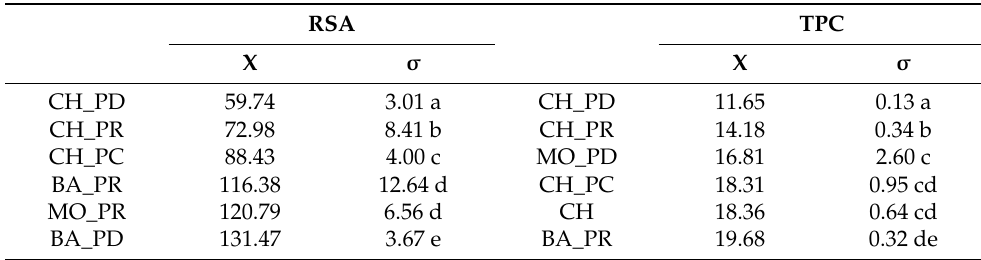
Table 5. Values (X—mean; σ —standard deviation) of radical scavenging activity (RSA; µ mol TE/g) and polyphenolic content (TPC; mg GAE/g) of GPs used as coagulants and results of variance analysis with post hoc Duncan’s test (BA—Barbera; CH—Chardonnay; PN—Pinot Noir; MO— Moscato; MAG—magnesium chloride; CIT—citric acid; PR—pre-distillation;